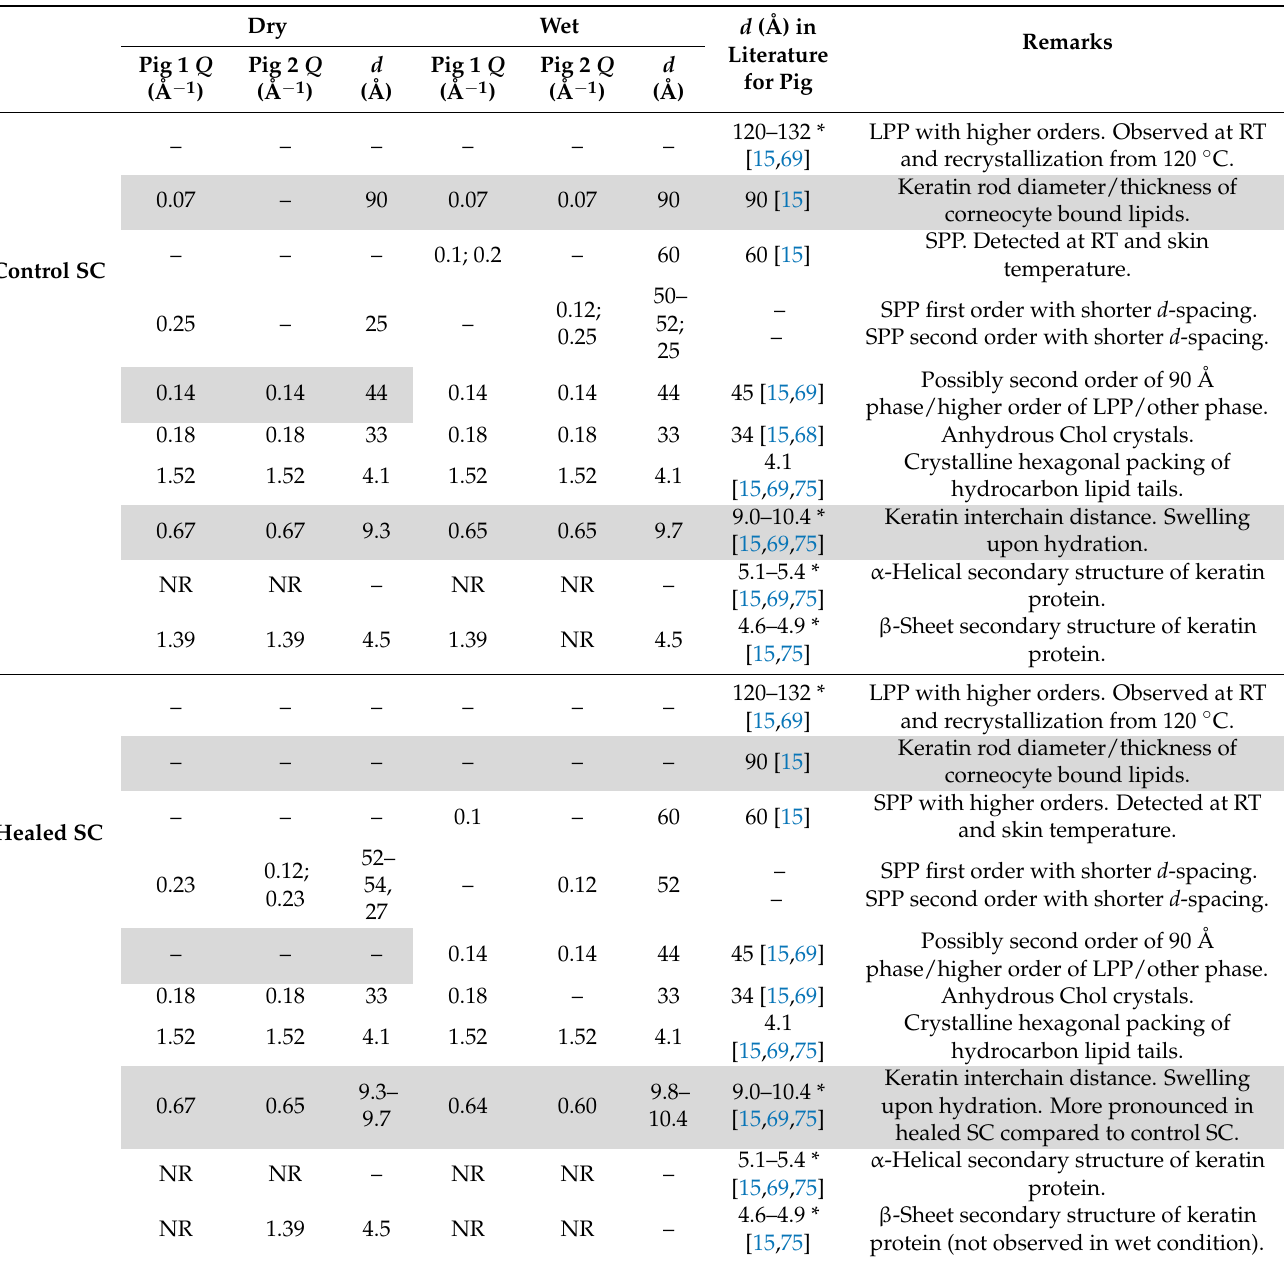
Table 2. Compilation of SWAXD peaks detected in control and healed SC spectra for both pigs at dry and wet conditions. The peaks are presented with their Q positions (Å − 1 ) and corresponding d -spacings (Å) and compared with d -spacings reported in the literature. The differences observed between control and healed SC at dry and wet conditions are highlighted in gray. (*)—indicates peaks for which higher diffraction orders are reported in the literature; NR—not resolved; RT—room temperature; Chol—cholesterol. All the SWAXD measurements were carried out at 32 ◦ C. Dry Wet d (Å) in Remarks Literature Pig 1 Q for Pig